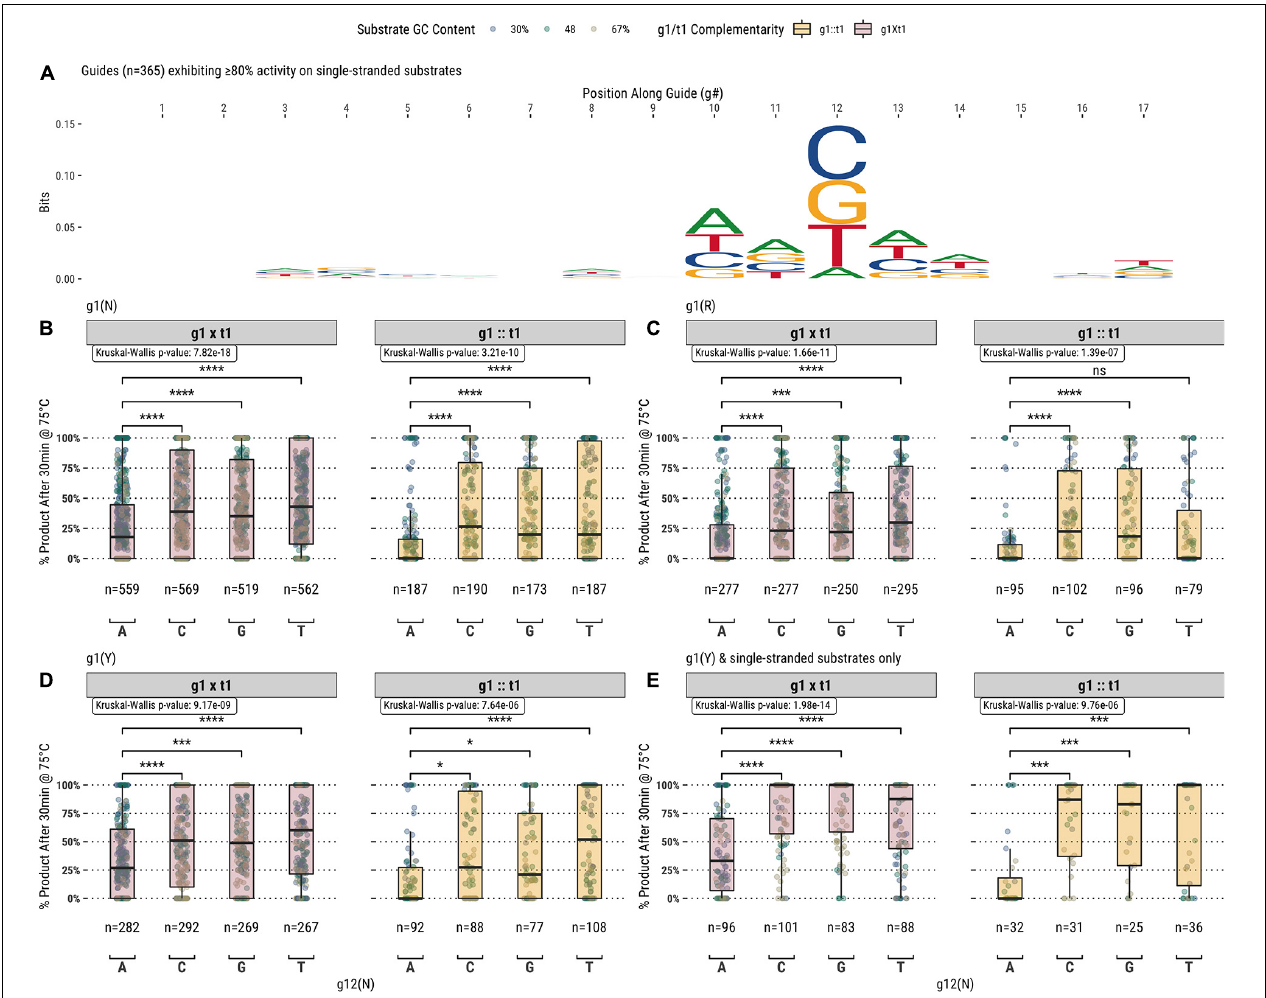
FIGURE 4 | (A) Aligning guides which, when used with TtAgo, exhibit high activity ( > 80% product after 30 min at 75 ◦ C) highlights some sequence preferences for specific locations along the guide (g1 excluded from the alignment). (B) The preference for g12B is exemplified by the low activity of guides possessing g12A on single- and double-stranded substrates. (C, D) Comparing g1R and g1Y populations, the identity of g12 appears to be decoupled from the lower activity observed with the less favored g1R identity. (E) The effect of g12 on activity remains for g1Y and single-stranded substrates only, which are more readily accessible by TtAgo. Boxplots have been annotated for statistical significance between relevant groups using the following labels: ns (not significant) for p > 0.05; ∗ for p ≤ 0.05; ∗∗∗ for p ≤ 0.001; and ∗∗∗∗ for p ≤